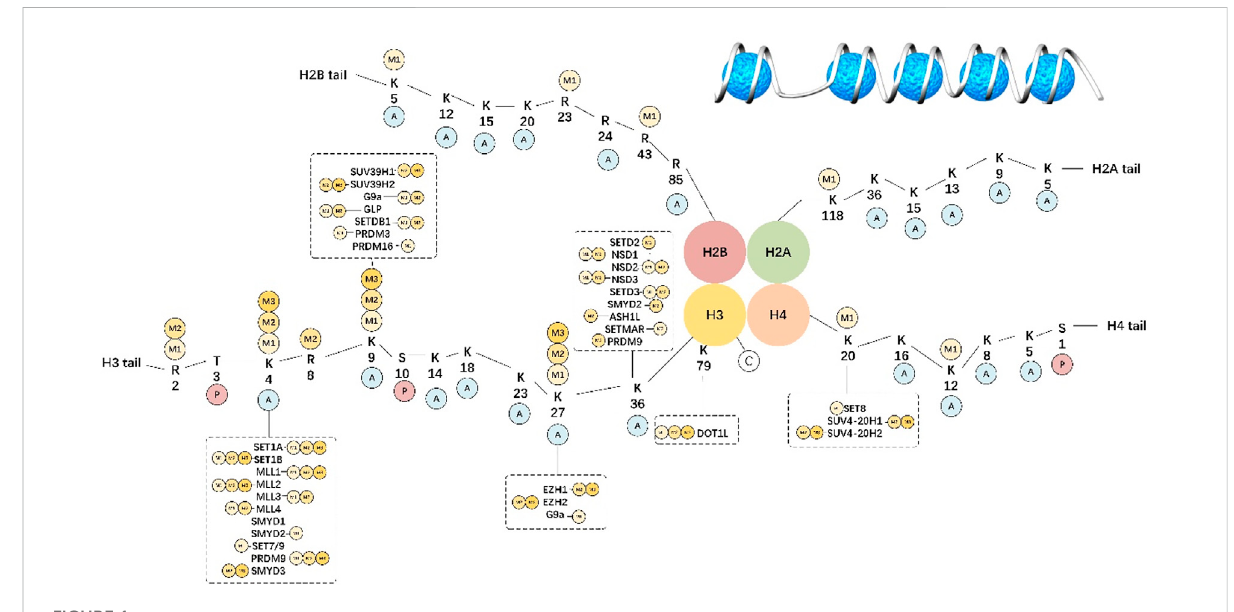
FIGURE 1 Histone methylation-speci fi c